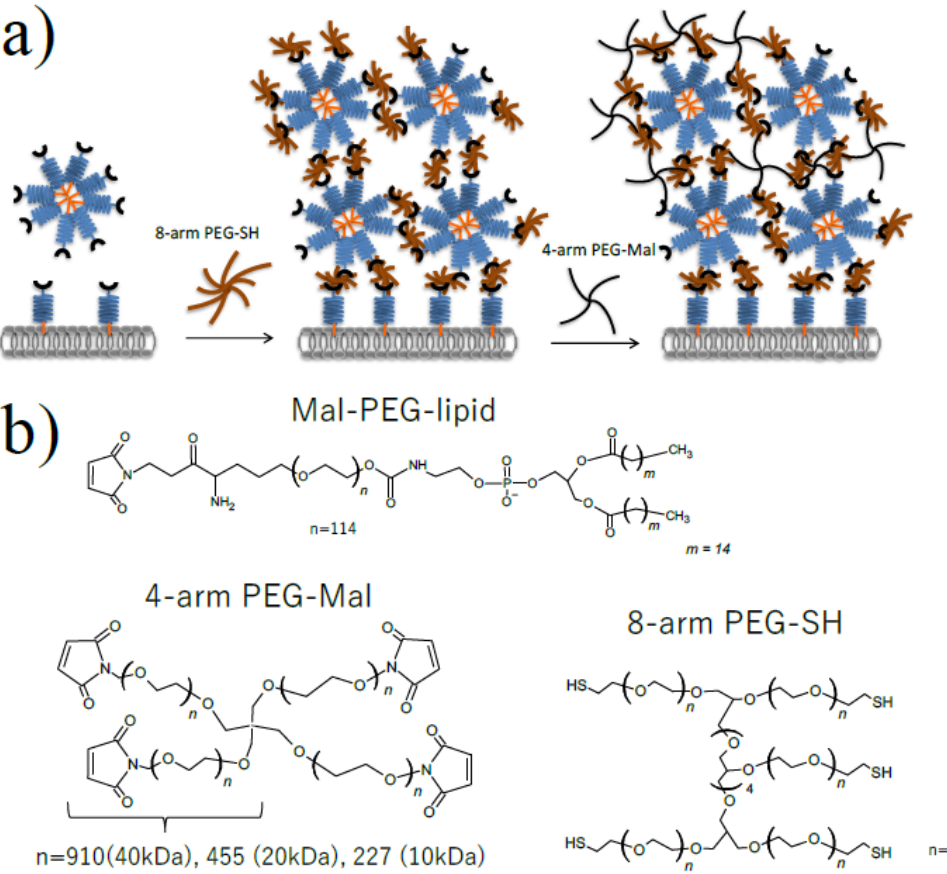
Figure 1. Microencapsulation of cells using Mal-PEG-lipid, 4-arm PEG-Mal and 8-arm PEG-SH. ( a ) Schematic illustration of cell microencapsulation ( b ) Chemical structure of Mal-PEG-lipid, 4-arm PEG(10k, 20k, 40k)-Mal and 8-arm PEG(20 kDa)-SH.